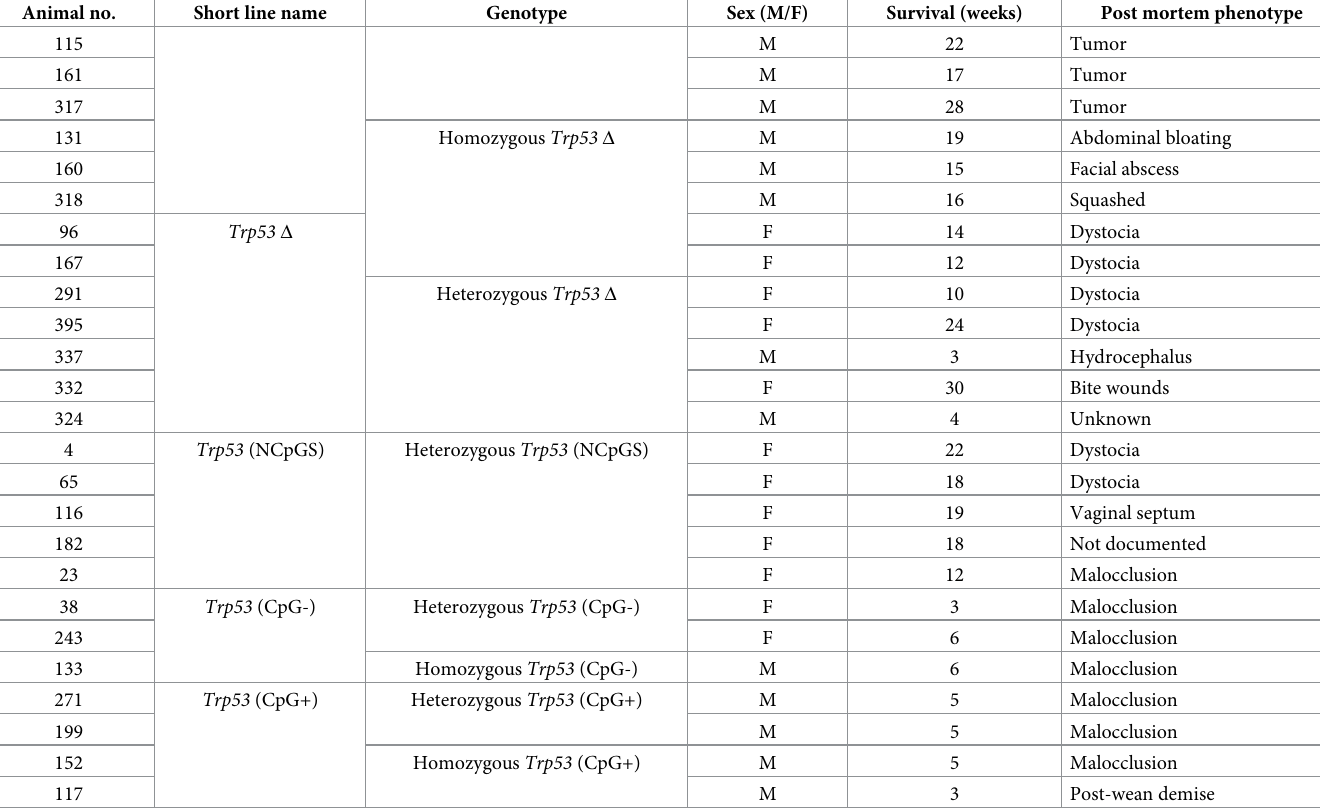
Table 1. Observed phenotypes in transgenic mice. Animal